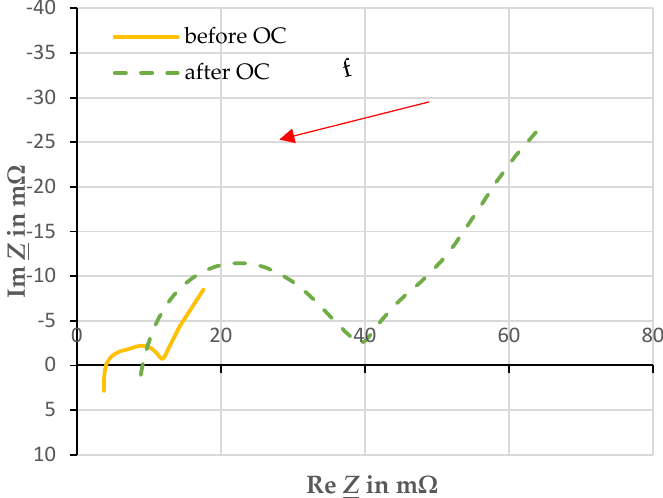
Figure 5. Comparison of electrochemical impedance spectroscopy before and after overcharging with a current of 1C and an ambient temperature of 20 ± 2 °C.